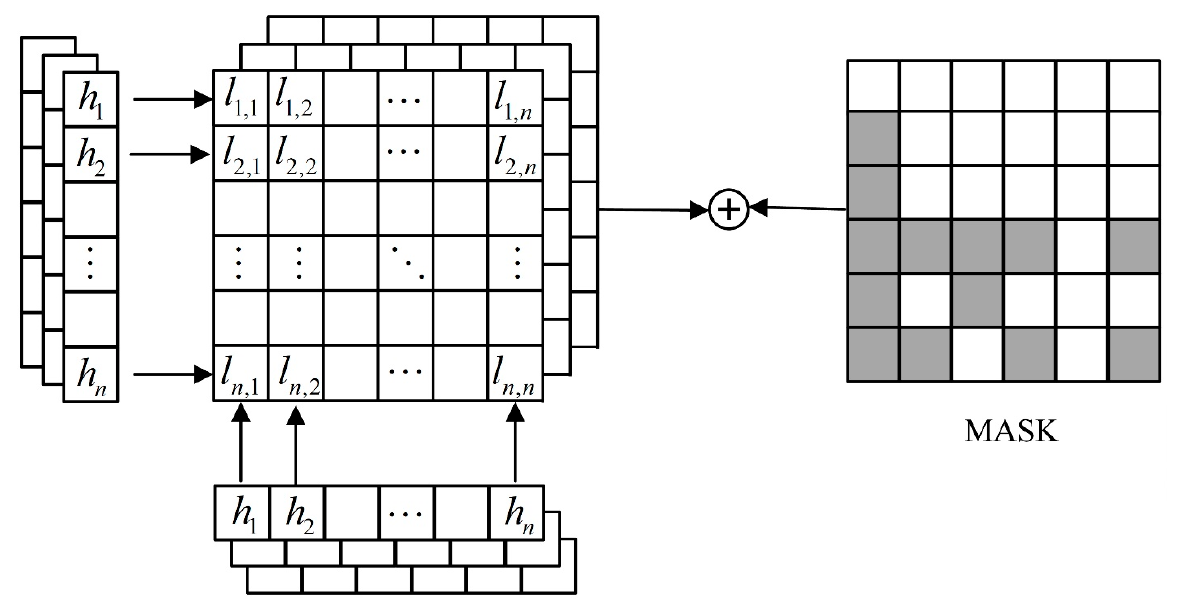
Figure 4. Multi-layer semantically encoded network structure diagram.